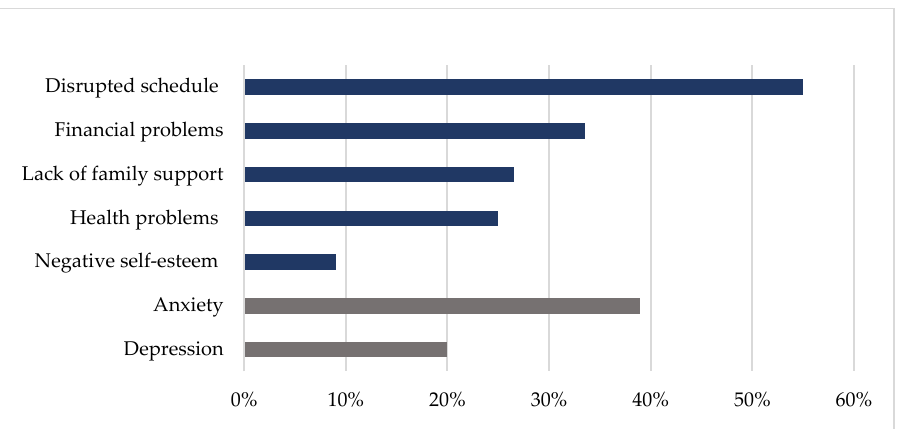
Figure 1. The percentage caregivers with significant relevant reactions/symptoms at baseline. For the Caregiver Reaction Assessment (CRA), a higher score on the self-esteem subscale indicates a positive caregiver reaction ( ≥ 4 = relevant), whereas the remaining four subscales represent negative effects of caregiving ( ≥ 3 = relevant). For the Hospital Anxiety and Depression Scale subdomains, a cut-off of ≥ 8 was used.